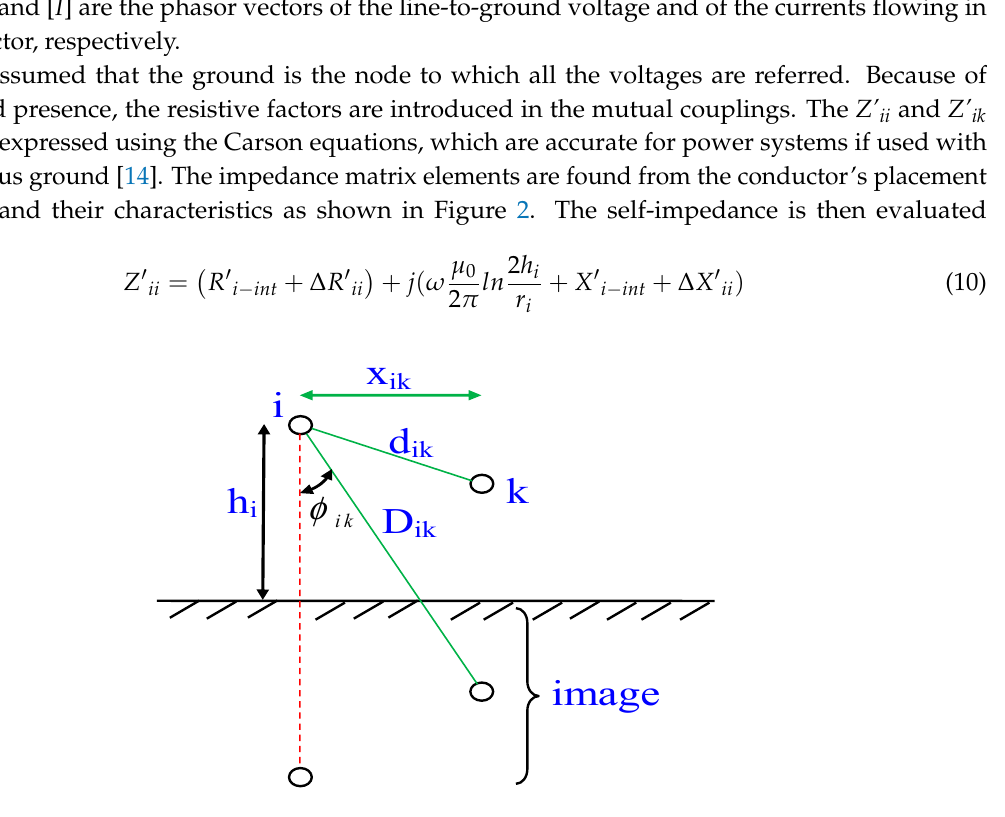
Figure 2. Geometry of the conductor’s placement.